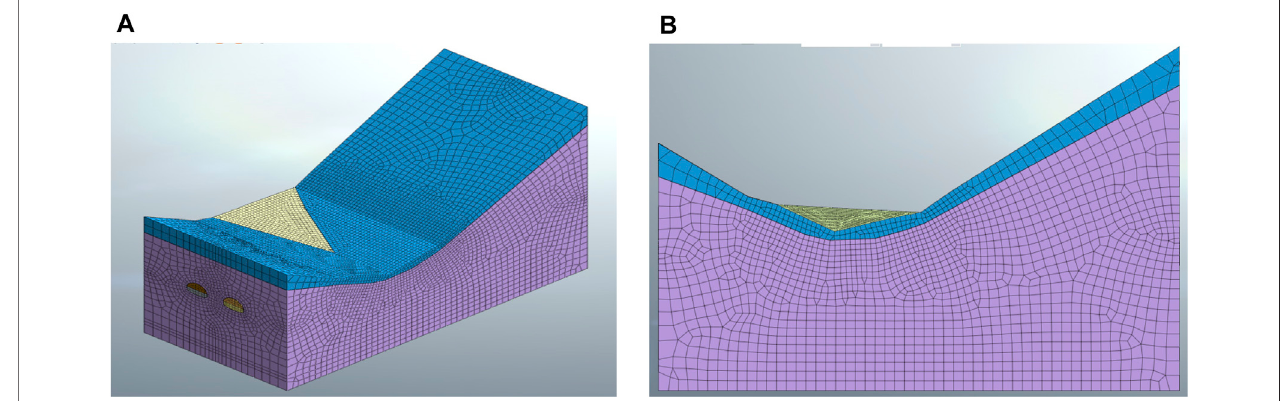
FIGURE 6 | Finite element model of Huangjiakuang tunnels: (A) Side view of the model and (B) the right view of the model.